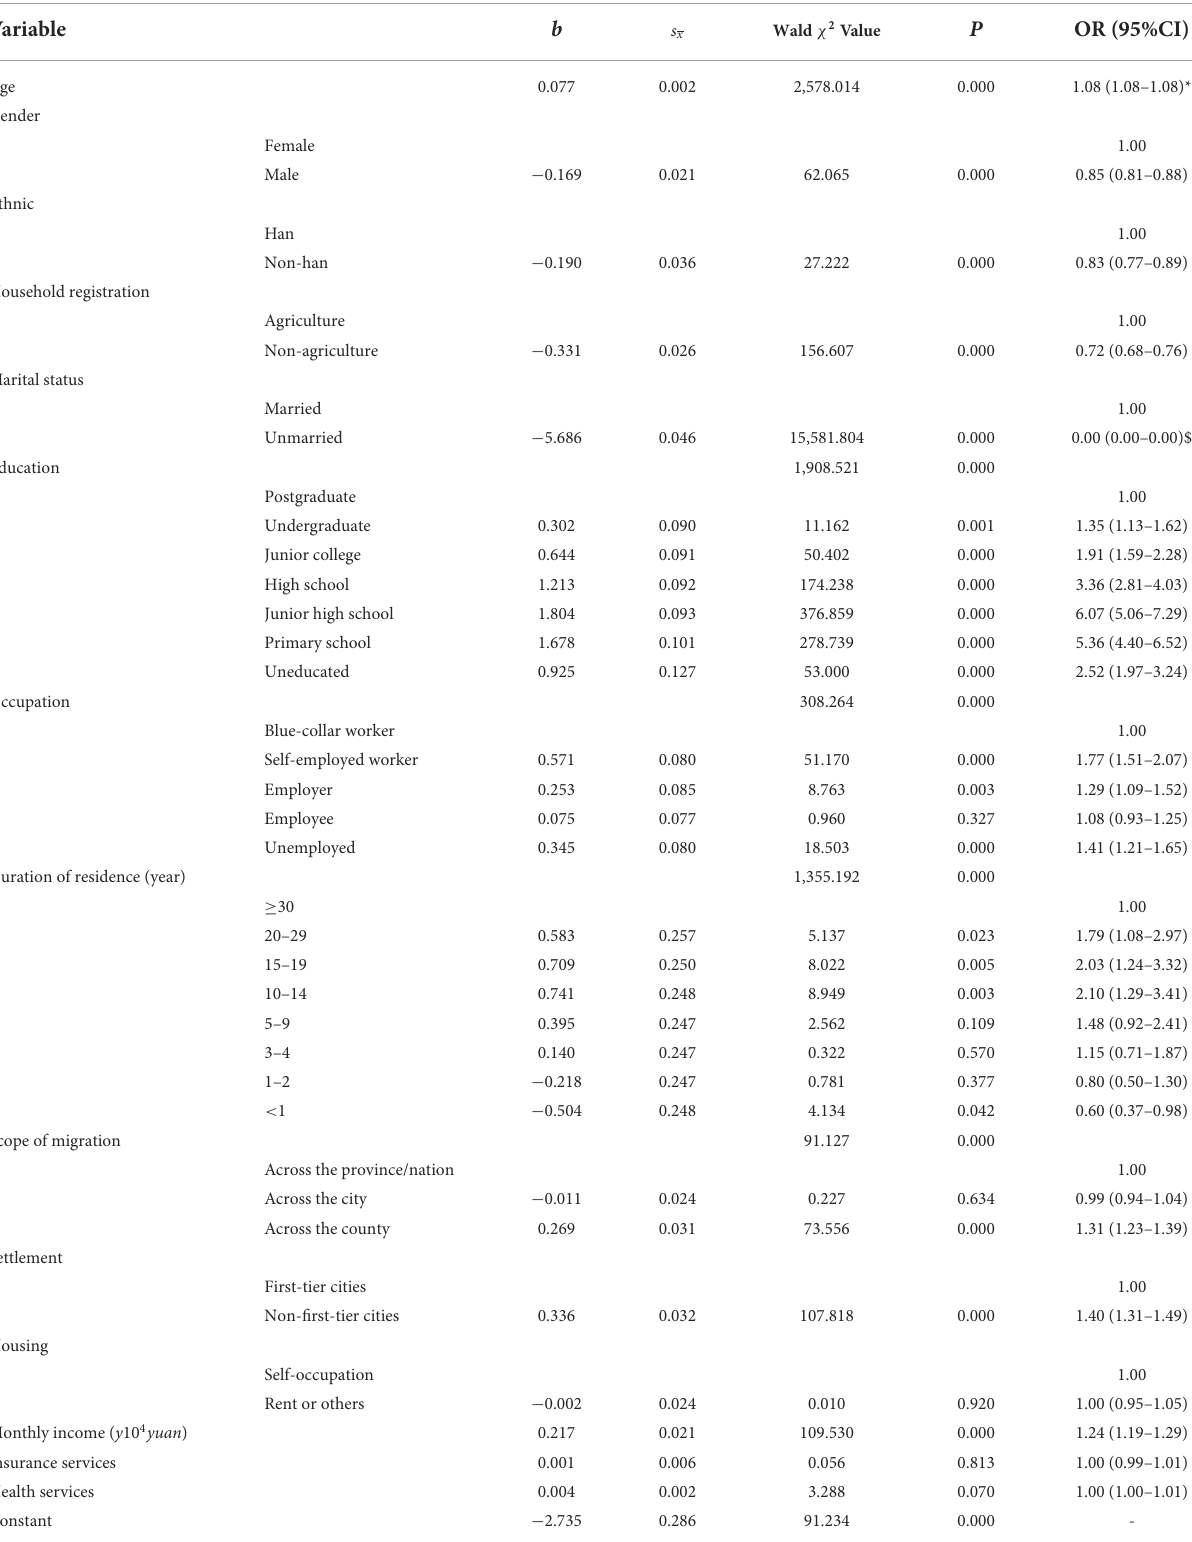
TABLE 4 Associated factors of the one-birth fertility behaviors of floating